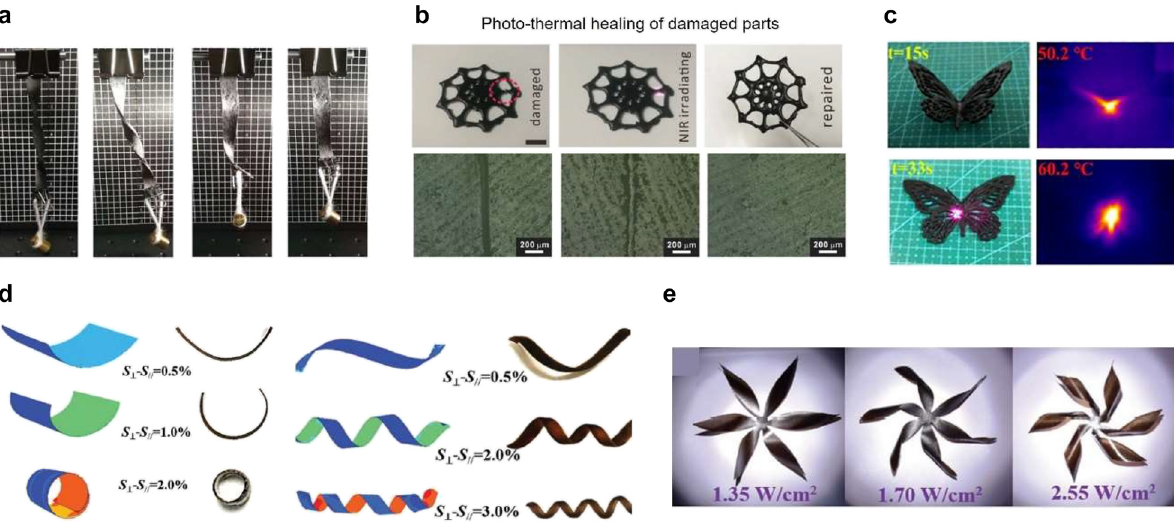
Figure 10: Photothermal activation of 3D-printed structures. DIW of Light-activated self-healable SMP structures : (a) images of a deformed strip recovering its shape under NIR light illumination. (b) Images of a damaged sample and the healing process using NIR laser irradiation. The SEM images of each step are also shown. Adapted fromRef.[130].Copyright(2019)RoyalSocietyofChemistry. FDMofNIR-activatedSMPstructure :(c)opticalandIRimagesofabutter fl yshape, which shows shape recovery by NIR light. Adapted from Ref. [131]. Copyright (2020) Elsevier. DIW of Multi-stimuli induced shape morphing in hydrogelstructures :(d)experimentalandsimulatedbendingandtwistingfordifferentstrainvalues.(e)Imagesof fl owerstructuresunderlight illumination. Adapted from Ref. [135]. Copyright (2020) John Wiley &